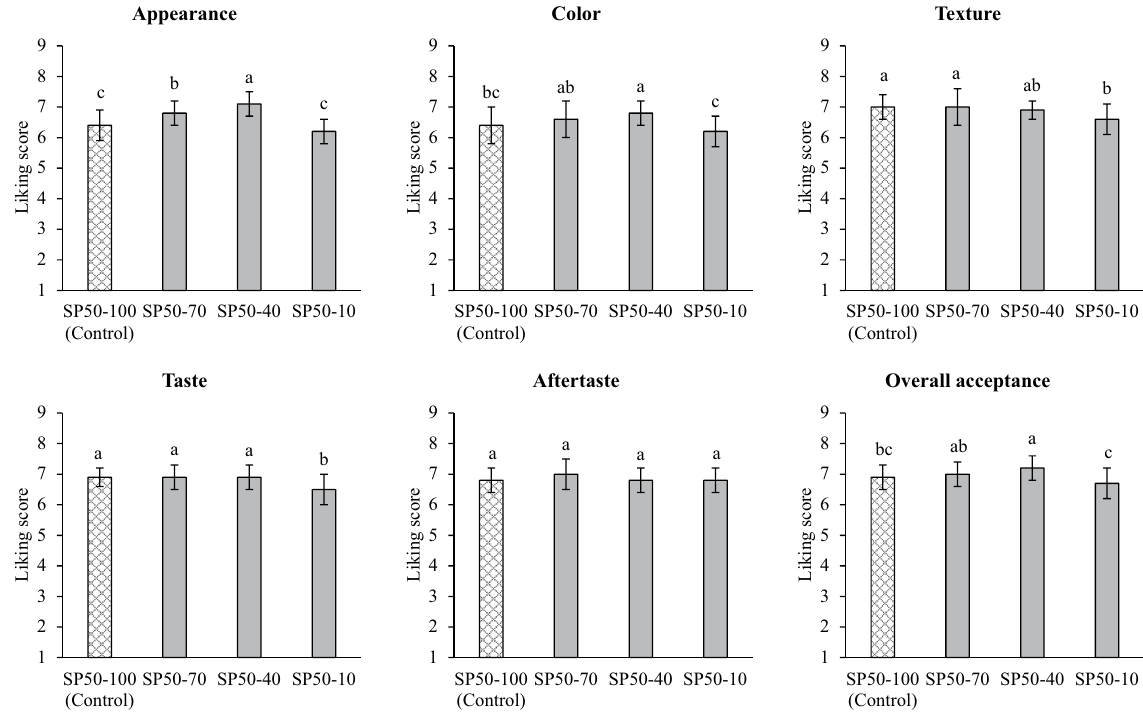
Figure 6. Sensory characteristics (liking score) of chicken bread spread-fortified with 50% of silkworm pupae with different levels of coconut oil. SP50-100 (Control): Chicken bread spread with 50% replacement of chicken by silkworm pupae without fat reduction (100% of coconut fat). SP50-70, SP50-40, and SP50-10: Chicken bread spread with 50% replacement of chicken meat by silkworm pupae using 70, 40, and 10% of coconut oil in control sample, respectively. Different letters on the bars indicate significant differences ( p ≤ 0.05). Parameters SP0-40